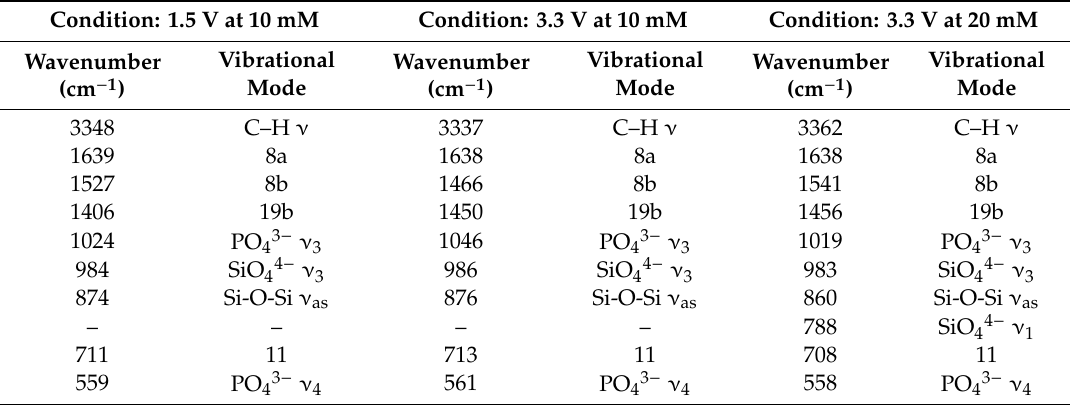
Figure 9. Infrared spectra of 1 nM pyridine on the supports doped for 2, 3 and 5 min in a 10 mM AgNO 3 solution at 1.5 V, and of 1 mM pyridine (black). Table 2. Main infrared bands and the vibrational modes they belong to from a 1 nM pyridine solution placed on the SiO 2 –HA doped at di ff erent time intervals (2, 3 and 5 min) using 1.5 and 3.3 V at 10 mM of AgNO 3 ; and 3.3 V at 20 mM of AgNO 3